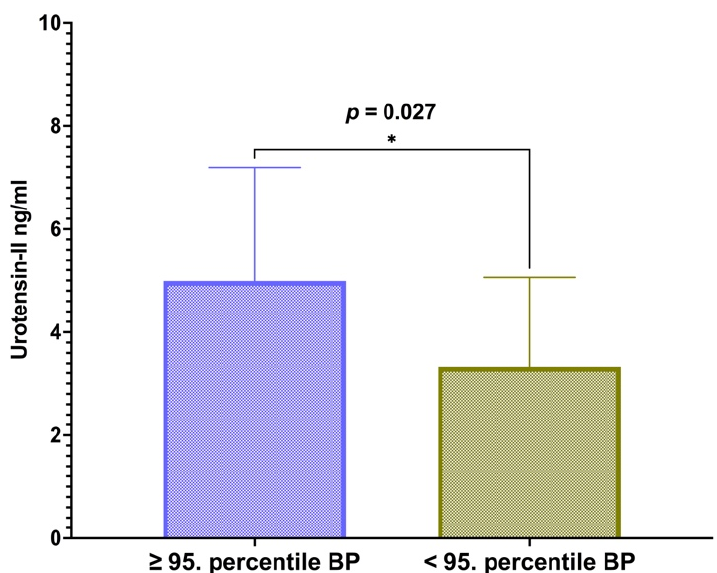
Figure 2. Association of urotensin-II with elevated systolic and diastolic blood pressure in obese children and adolescents. * Significance level ( p ) was set to <0.05.